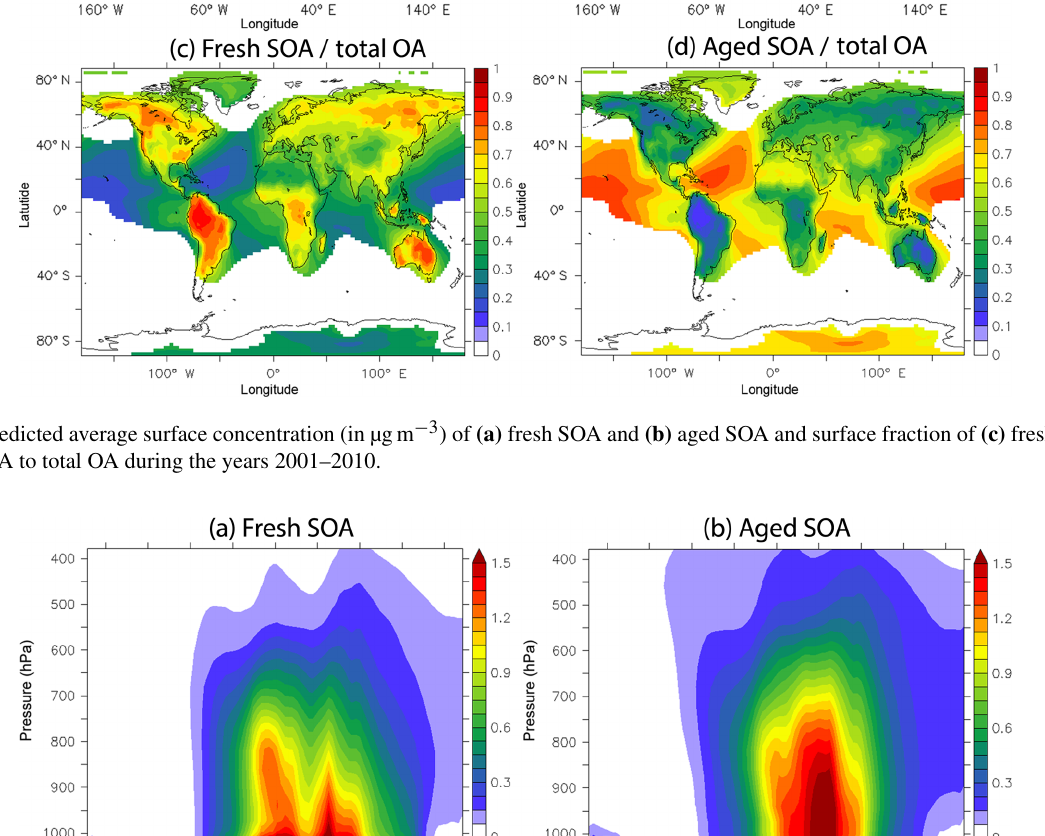
with C ∗ ≤ 10 − 2 µg m − 3 , while the top line represents all the species with O : C ≥